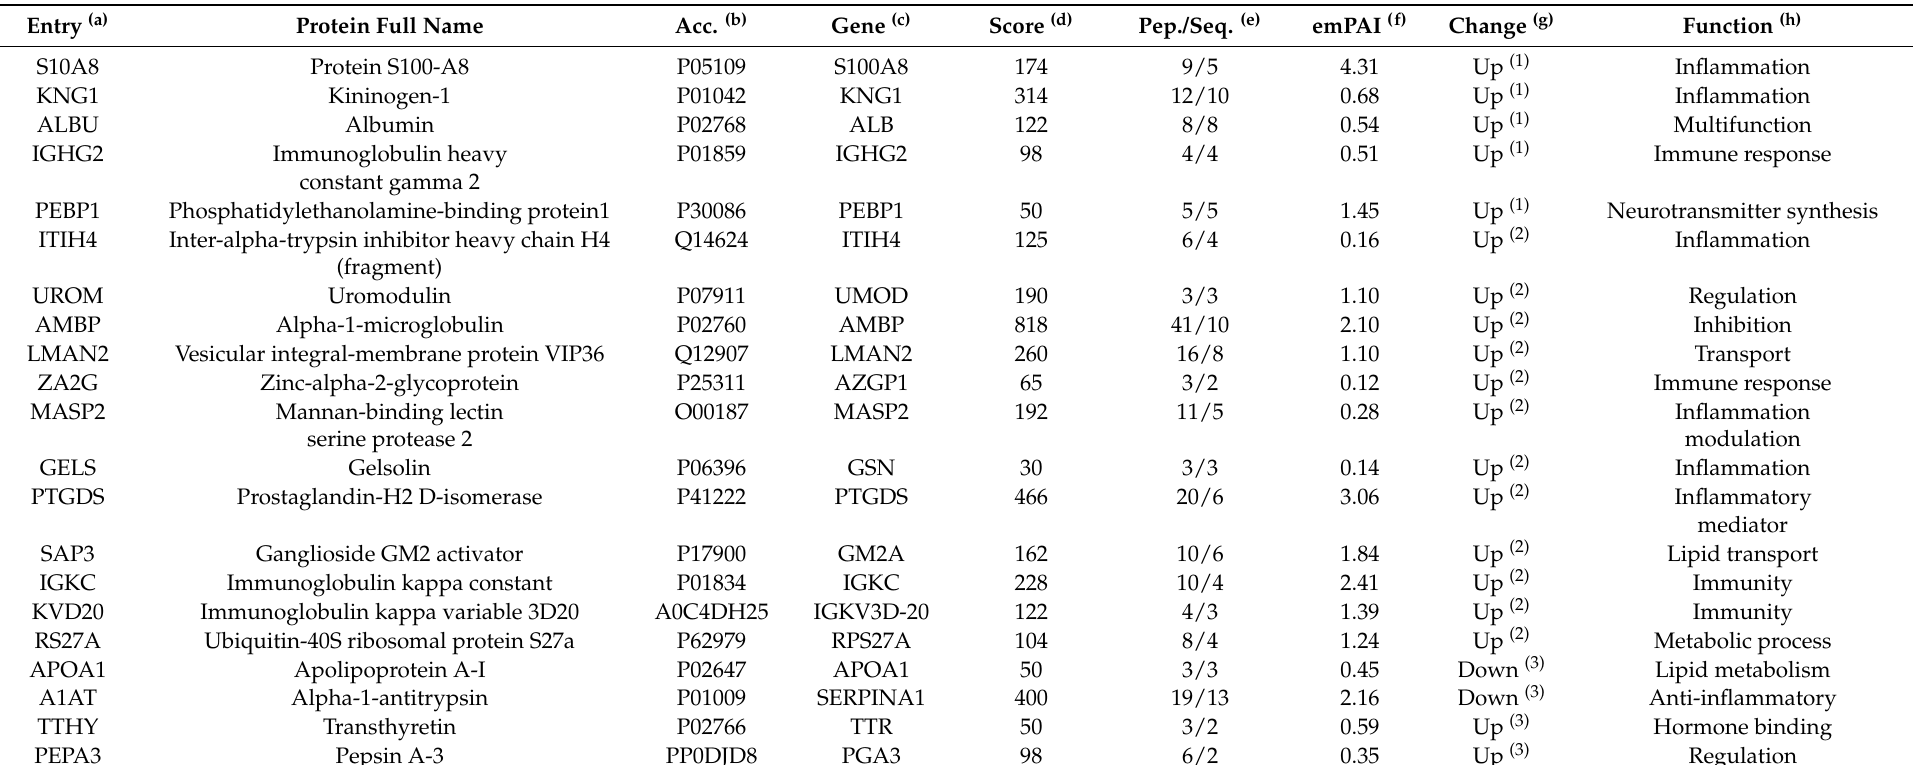
Table 2. Differentially expressed urinary proteins identified by LC-MS/MS after 2DE